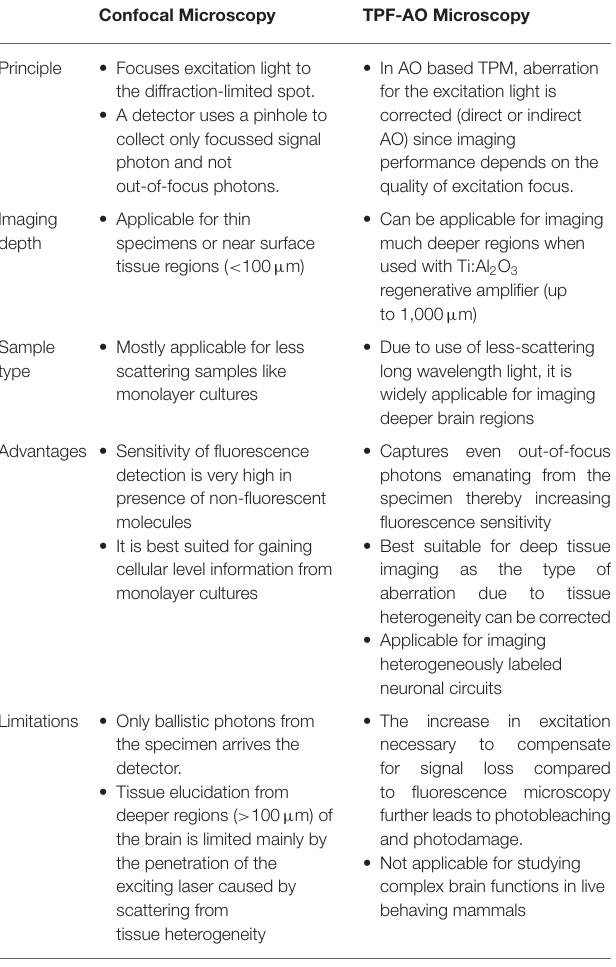
TABLE 1 | Comparison of microscopy techniques with and without Adaptive optics. Confocal Microscopy TPF-AO